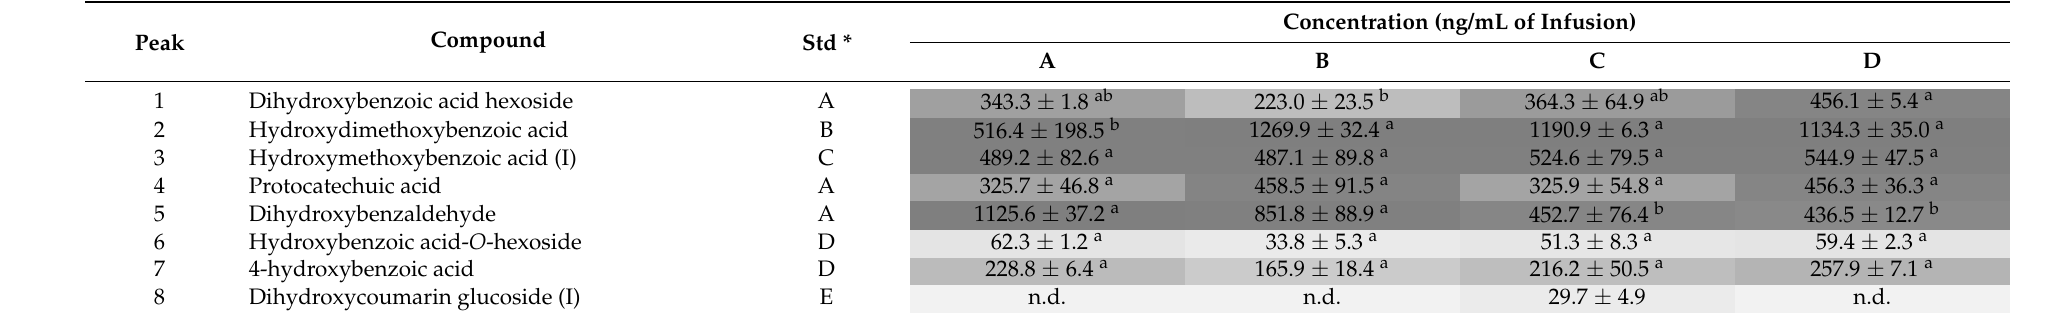
Table 4. Quantification of compounds detected in rosemary infusions by UHPLC-ESI-QTOF-MS (ng of compound/mL of